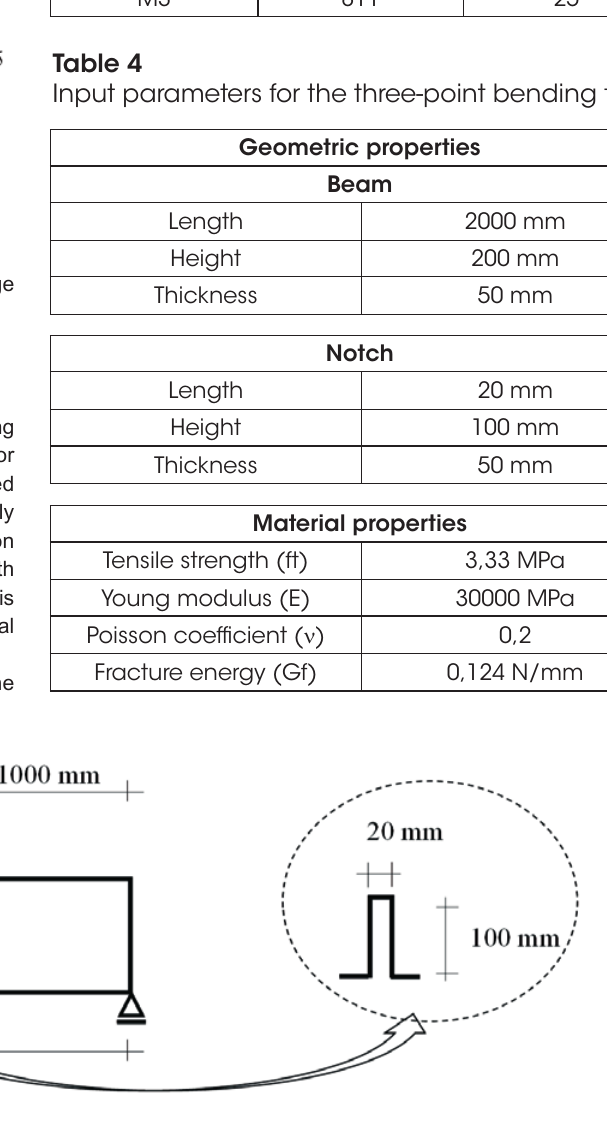
Beam geometry and boundary conditions – three-point bending test